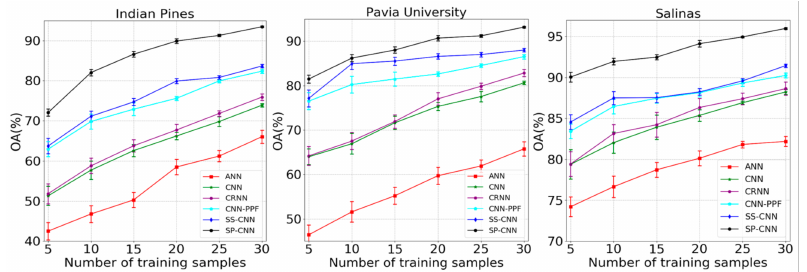
Figure 8. Variation of classification accuracy with the increase of number of training samples.